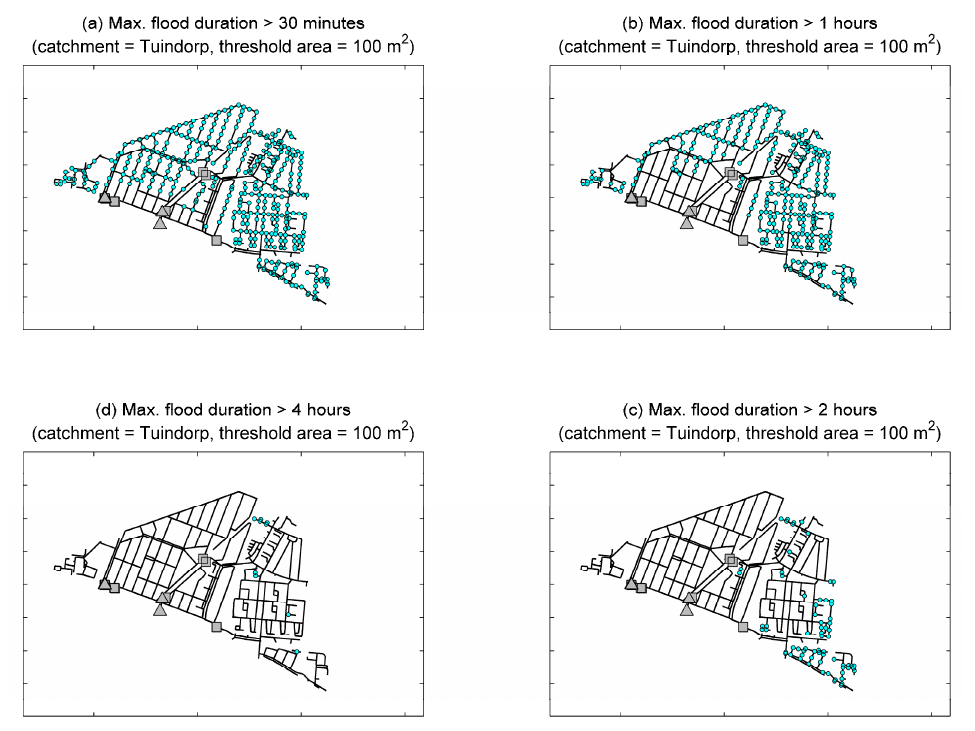
Figure 8. Manholes in the ‘Tuindorp’ catchment with an increasing maximum flood duration: ( a ) Larger than 30 min; ( b ) Larger than one hour; ( c ) Larger than two hours; ( d ) Larger than four hours.